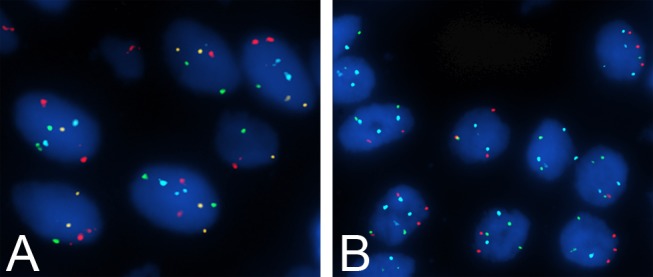
FISH results for the two tumor types.The cases that exhibited a gain of at least 2 of chromosomes 3 (B), 7 (B) and 17 (A, B) or a homozygous loss of 9p21 (B) were defined as UroVysion FISH positive.